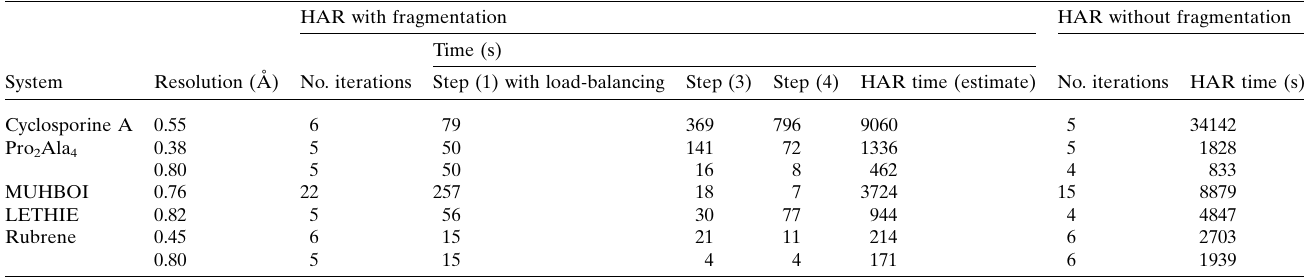
Table 4 Timings for steps (1)–(4) for a number of the systems used in this work. Step (1) timing given for the first iteration of HAR for calculations with load-balancing, time for steps (3) and (4) is an average over HAR iterations, ‘HAR time (estimate)’ corresponds to the estimated time of refinement with the use of